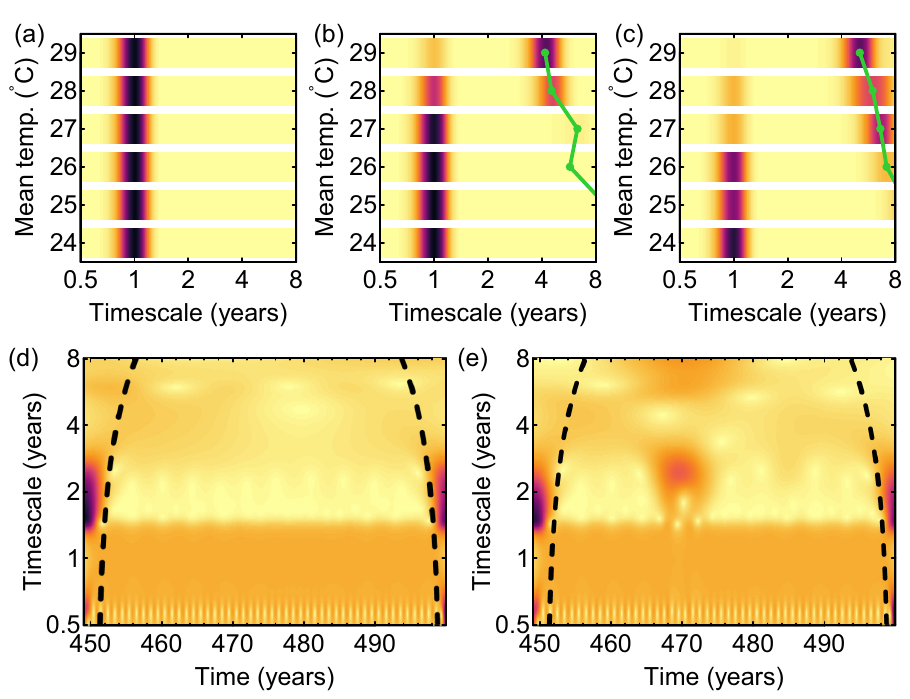
Fig 4. Multiannual periodicities and synchrony for models driven by simple seasonal sine curves. (a–c) Mean wavelet power for simulation 2 experiments (seasonal temperature input with no multiannual components; Table 1) per timescale for each of the 6 hypothetical locations (rows within each panel), assuming a mean cross-protection of (a) 6 months, (b) 1 year, and (c) 2 years. (d) Mean wavelet field for the simulations in (b) (i.e., assuming a cross-protection of 1 year) and (e) mean wavelet field for the same simulation, except for the introduction of a single 4-year fluctuation across all locations on year 468. The amplitude of the multiannual fluctuation here is 20% of that of the seasonal cycle. Darker colours indicate greater wavelet power (colours in a–c and d–e are (separately) on the same scale). Green lines in (a–c) indicate peaks in mean wavelet power over multiannual timescales. Edge effects in the WTs may influence results before and after the dashed lines in (d, e). See S19–S32 Figs in S1 Appendix for more complete results (across all cross-protections, and timescales and amplitudes of the multiannual fluctuation). The underlying data are in S1 Data at https://github.com/UF-IDD/synchrony_dengue_figures. WT, wavelet